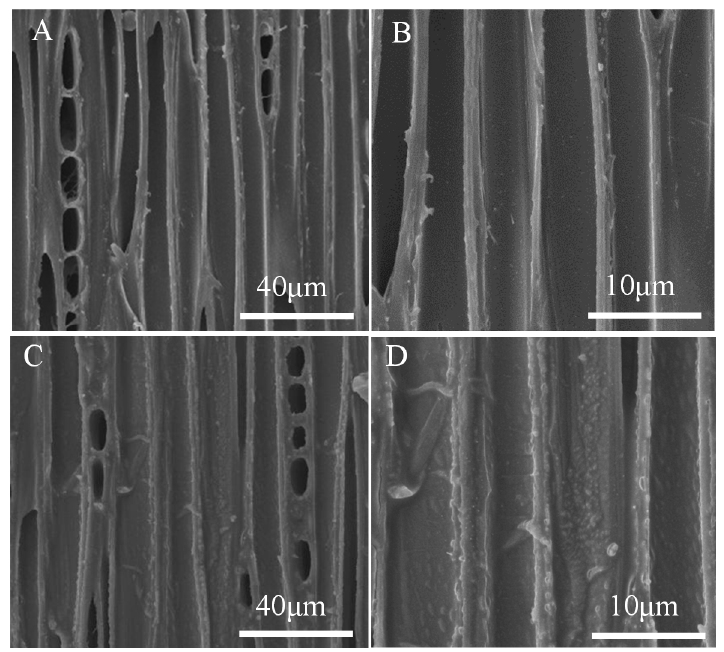
Figure 6. The SEM images of wood samples on tangential section: ( A , B ) untreated wood; ( C , D ) PDMS@wood.